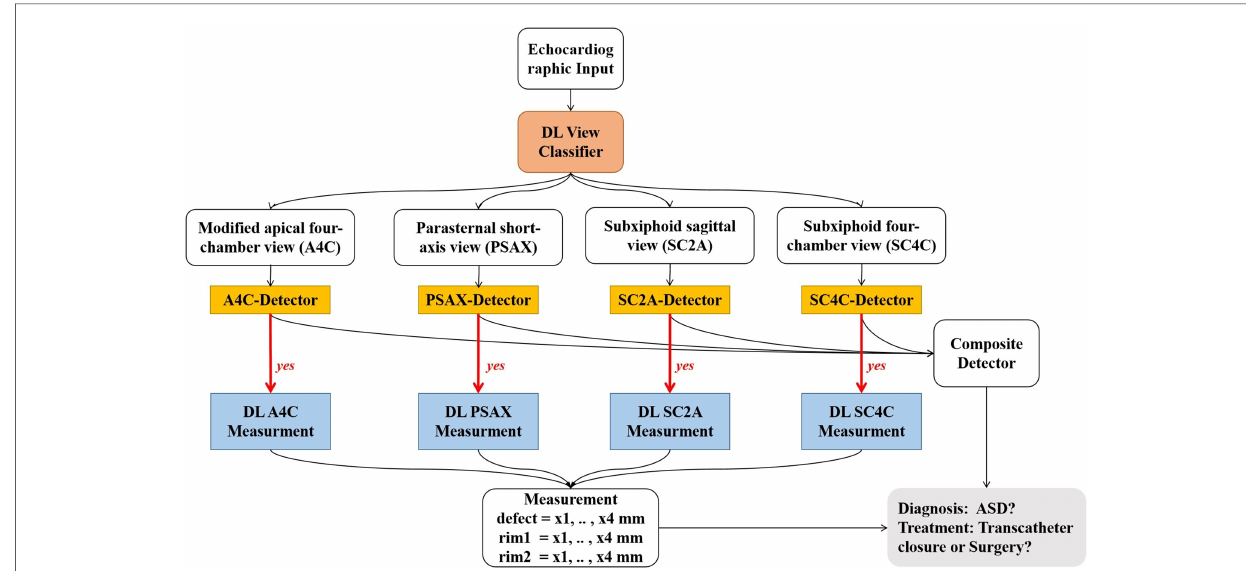
FIGURE 1 Work fl ow of the ensemble model. Step 1: raw echocardiographic videos are separated for classi fi cation of views (red box). Step 2: disease detection models use different views to detect the presence of ASD (orange rectangles). Step 3: if ASD is present (denoted by “ yes ” ), metrics associated with severity of ASD are assessed (blue rectangles). DL, deep learning; ASD, atrial septal defect.